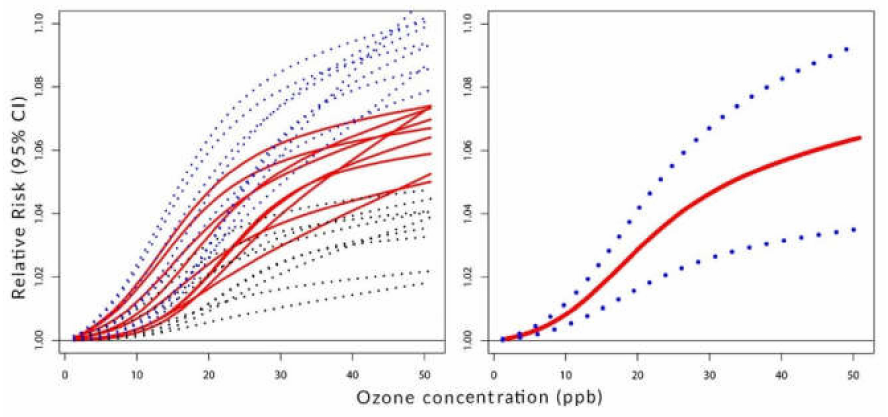
Figure 3. Left panel : C-RF shapes by lags. Right panel : a pooled C-RF shape. Transformation with f(Z) chosen among three simple functions.